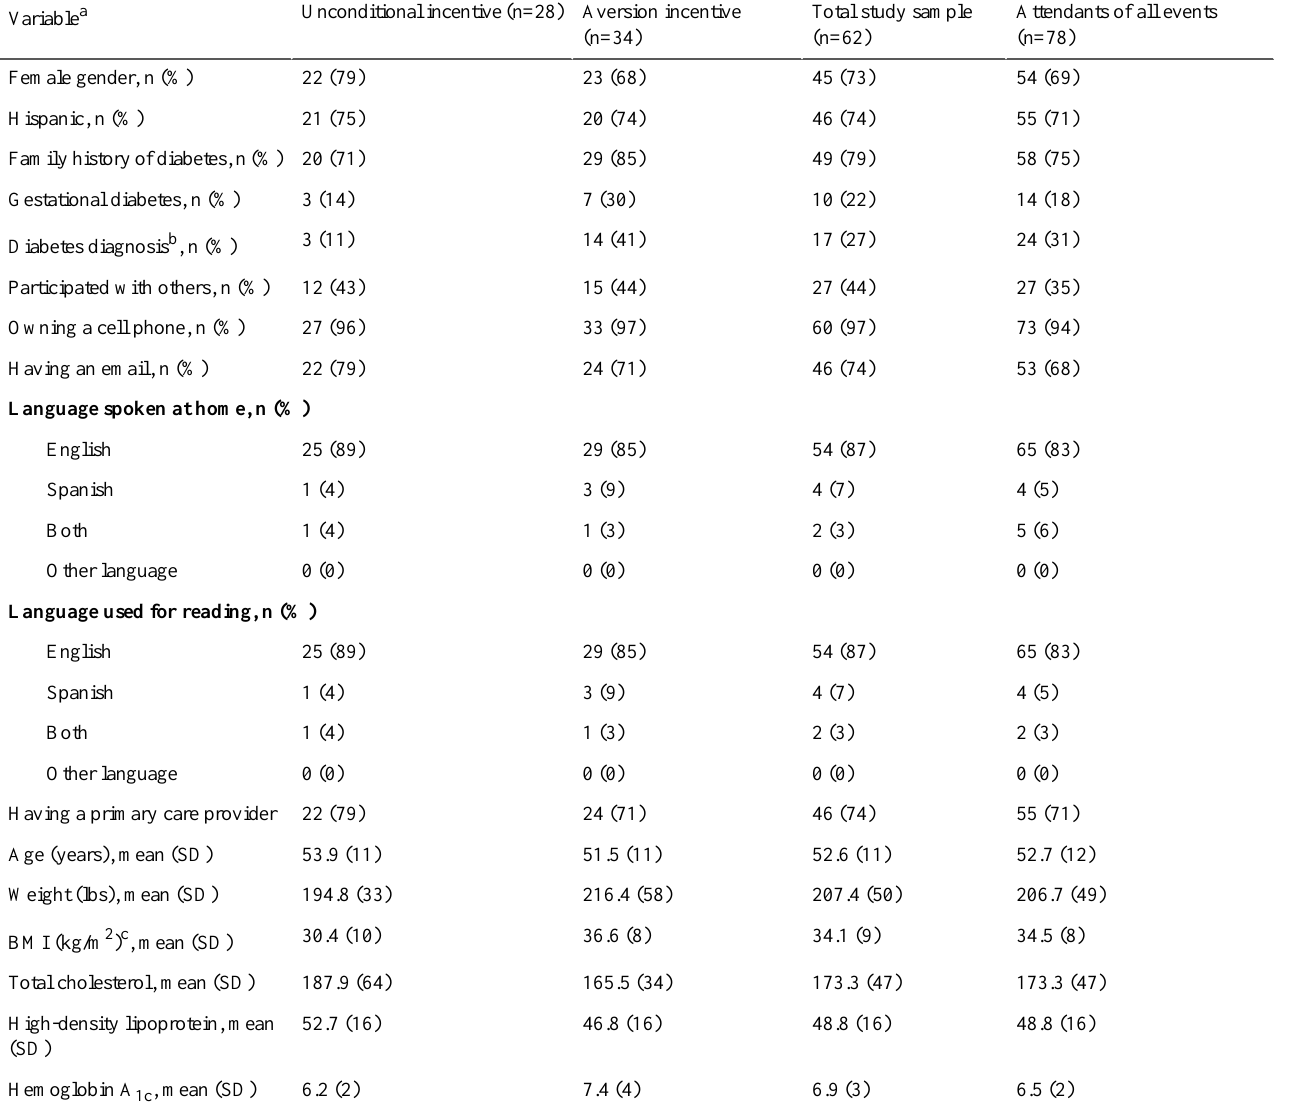
Table 3. Characteristics of study sample and screened residents.